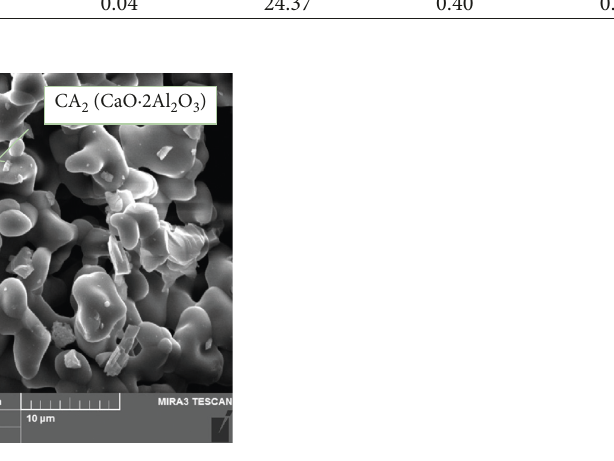
Figure 5: SEM image of synthesized CA Table 4: Phase composition of anhydrous binders.